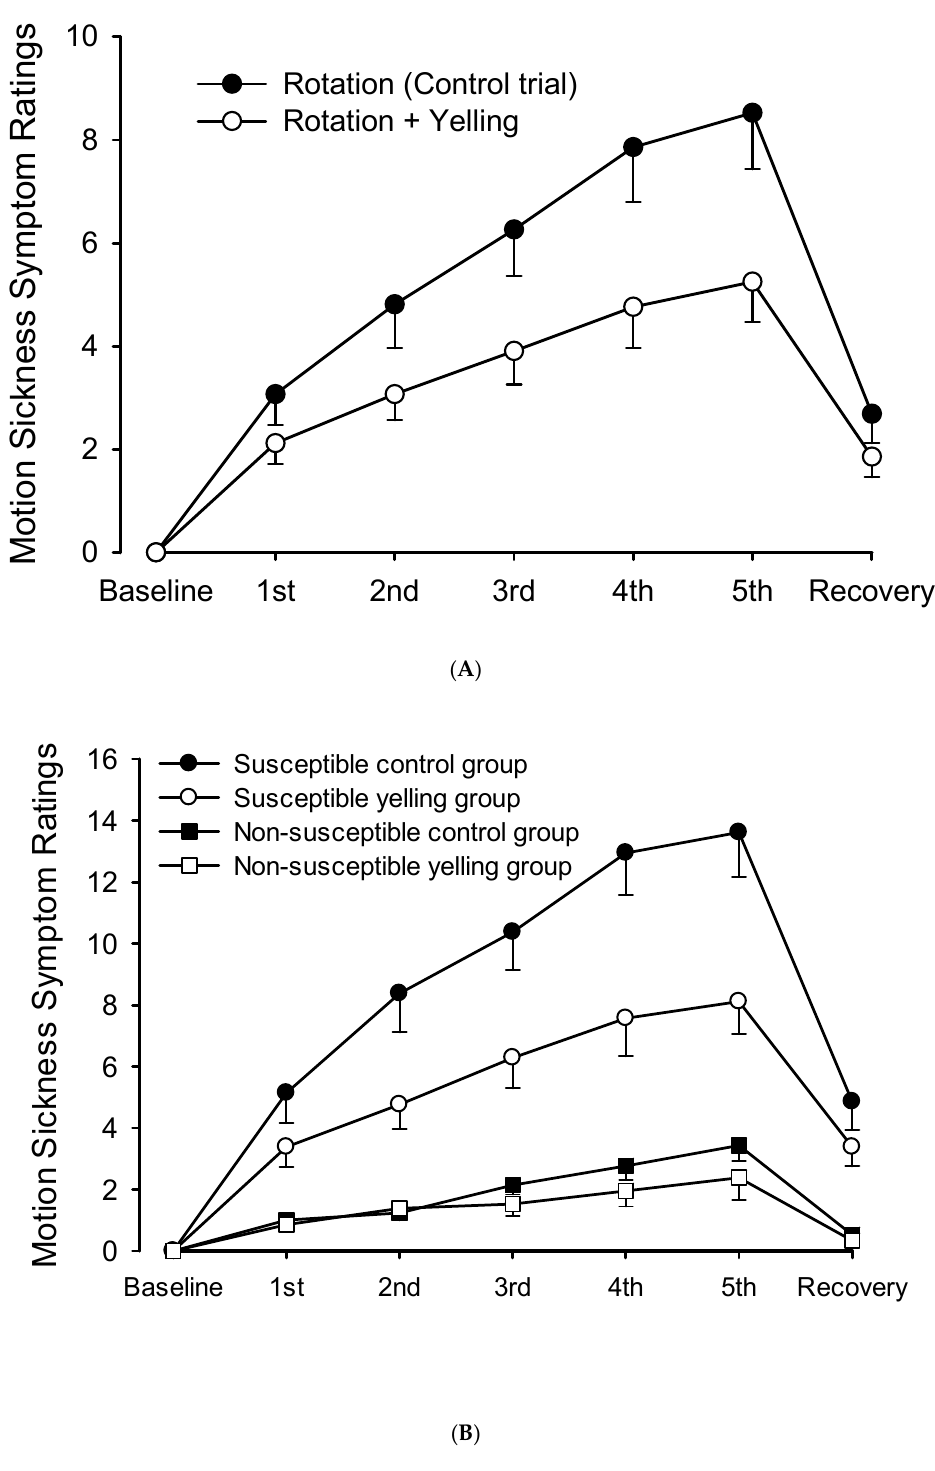
Figure 2. Scores of motion sickness symptoms during intermittent rotations and its recovery period. ( A ) The yelling intervention could significantly reduce motion sickness scores. ( B ) It significantly decreased motion sickness scores in the susceptible group. However, changes were not evident in the non-susceptible